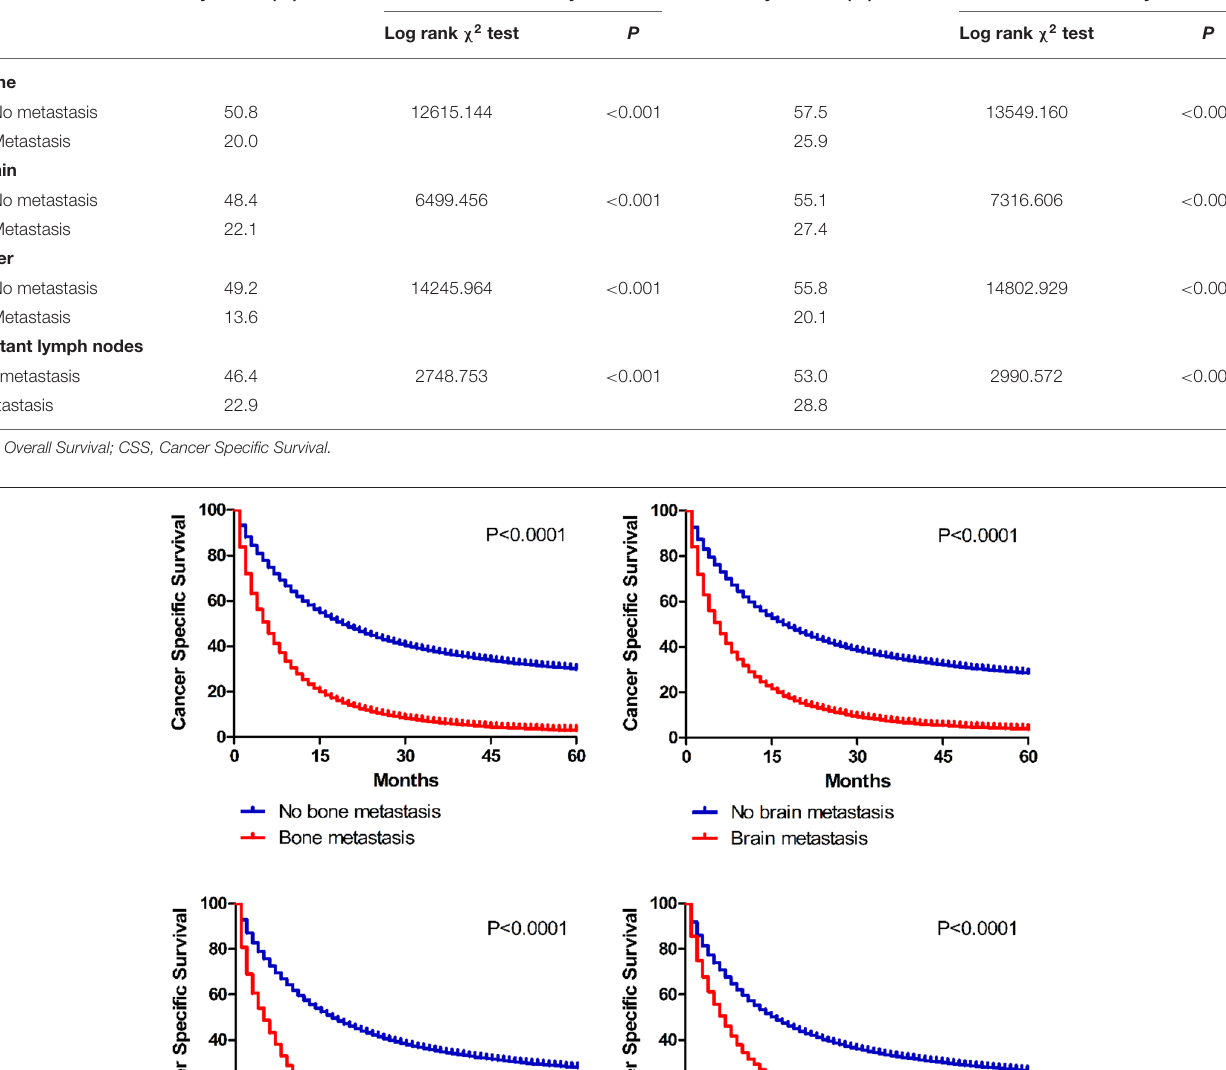
Frontiers in Oncology |